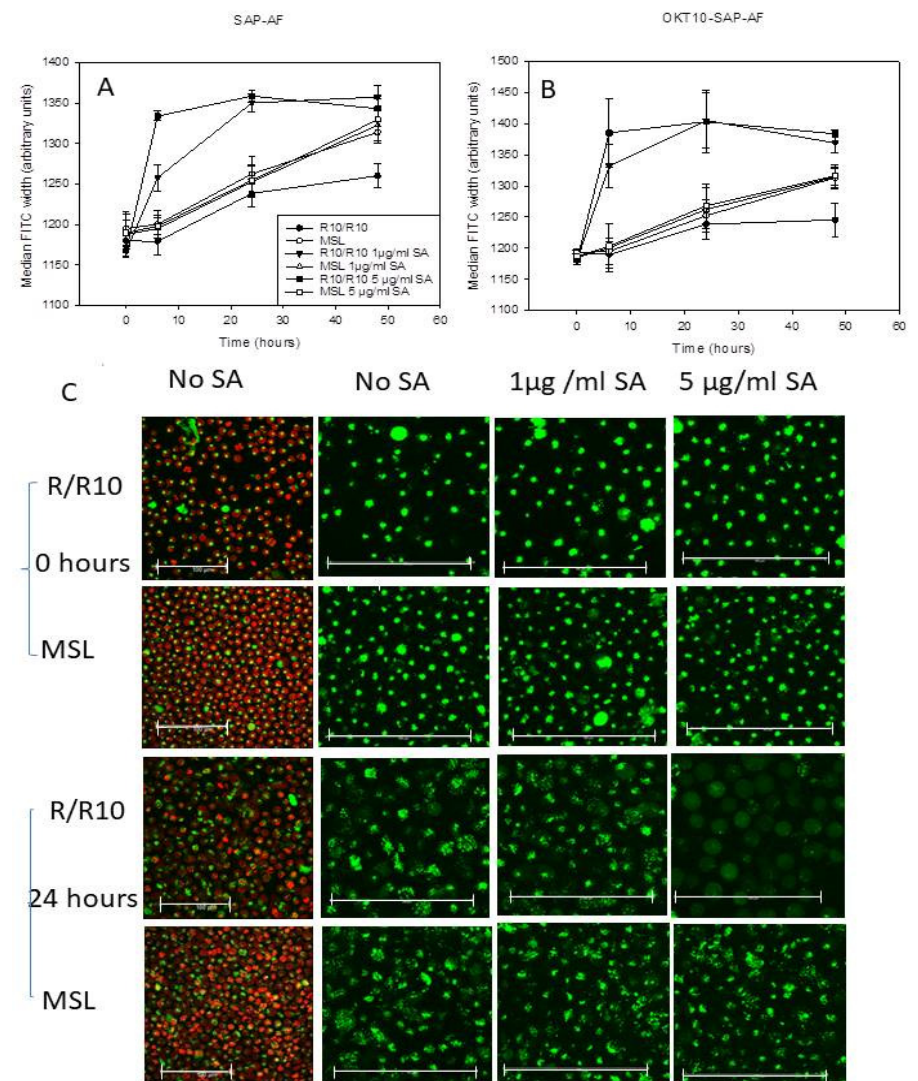
Figure 2. Lipid depletion of Daudi cells reduces the SA-augmented endolysosomal escape of OKT10-SAP-AF and SAP-AF. Change in FITC width for Daudi cells incubated with M β CD for 1 h followed by incubation in delipidated R10 containing lovastatin for 24 h (MSL) with SAP-AF ( A ) or OKT10-SAP-AF ( B ) for 20 h with or without ( ○ ) exposure to 1 ( ∆ ) or 5 ( □ ) µg/mL SA compared to mock-treated Daudi cells incubated in R10 in the absence ( ● ) or presence of 1 ( ▼ ) or 5 ( ■ ) µg/mL SA. Data presented are the mean values of three experiments and the error bars represent the standard deviation either side of the mean. ( C ) Confocal images of lipid deprived, and mock-treated control Daudi cells loaded with SAP-AF (green) for 20 h prior to the exposure to 1 or 5 µg/mL SA for zero or 24 h. Endolysosomal escape is seen as a change from a punctate compartmentalised distribution to a diffuse fluorescence throughout the cytoplasm. The images taken in the absence of SA are shown both with and without Hoechst 33342 nuclear stain (red). Images presented are the maximum projections of a series of 21 z- slices at 1 µm spacing and are representative of two independent experiments. Scale bar represents 100 µm.